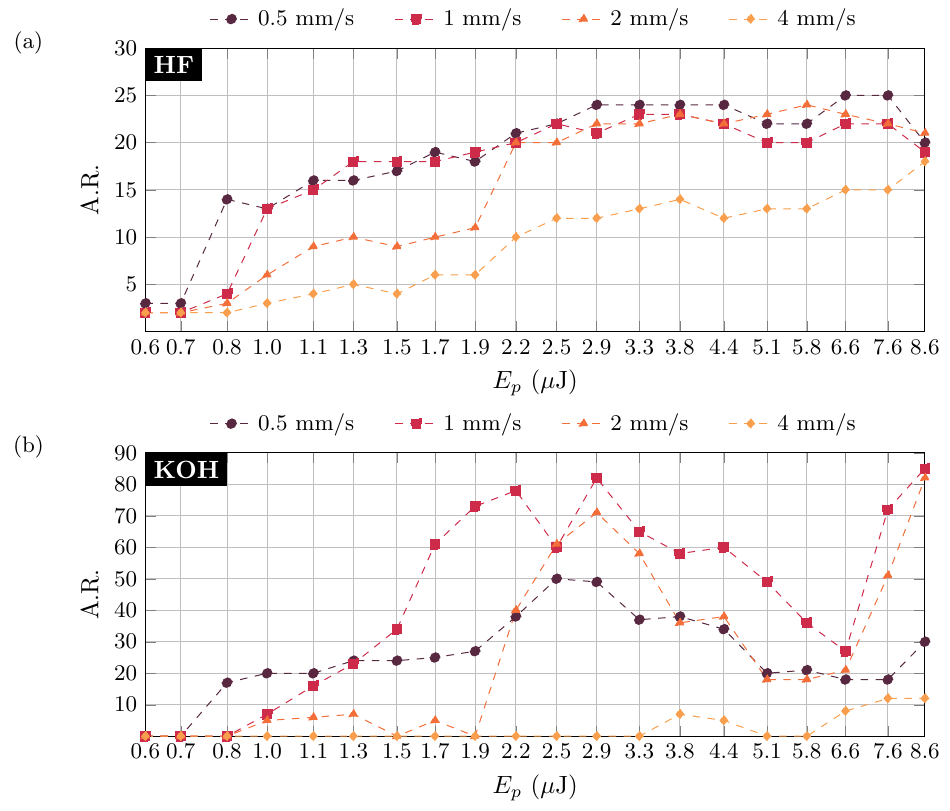
Figure 3. Measured A.R. of the etched cones, for tracks irradiated with different pulse energy E p and different translation speed v t . Laser polarisation was kept orthogonal to the translation direction. The plotted values correspond to the averages of the measured A.R. of two different cones, obtained by tracks irradiated with identical parameters. Panel ( a ) refers to 10-min etching in HF solution, while panel ( b ) refers to 6-h etching in KOH